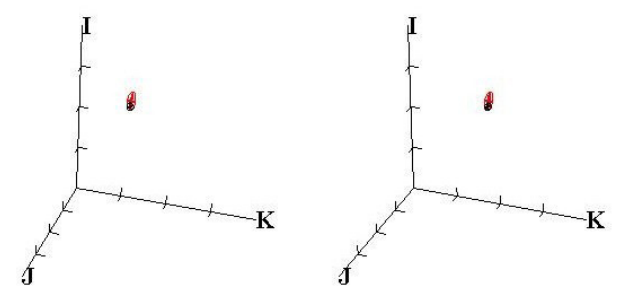
Figure 9 . 95% confidence ellipsoids for the first subject in the control group. C1 is represented by the black ellipsoid and C2 is represented by the red ellipsoid. Data points were not included to enhance visibility of the confidence ellipsoids. The origin is 45.65 I